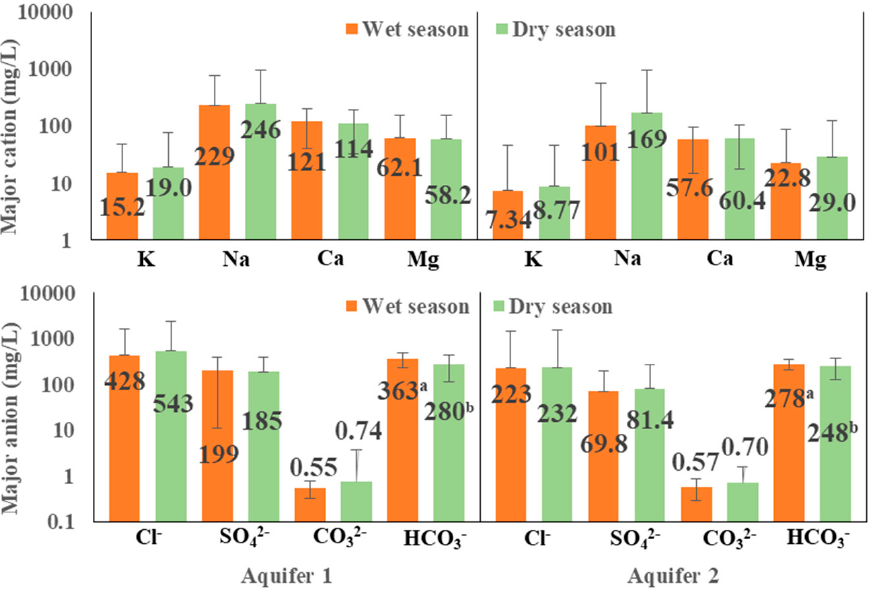
Figure 3. The mean concentrations of major cations and anions in addition to statistical results in Aquifer 1 and Aquifer 2 between the wet and dry seasons. (a superscript character after the mean value means that the water quality parameter has significant differences).